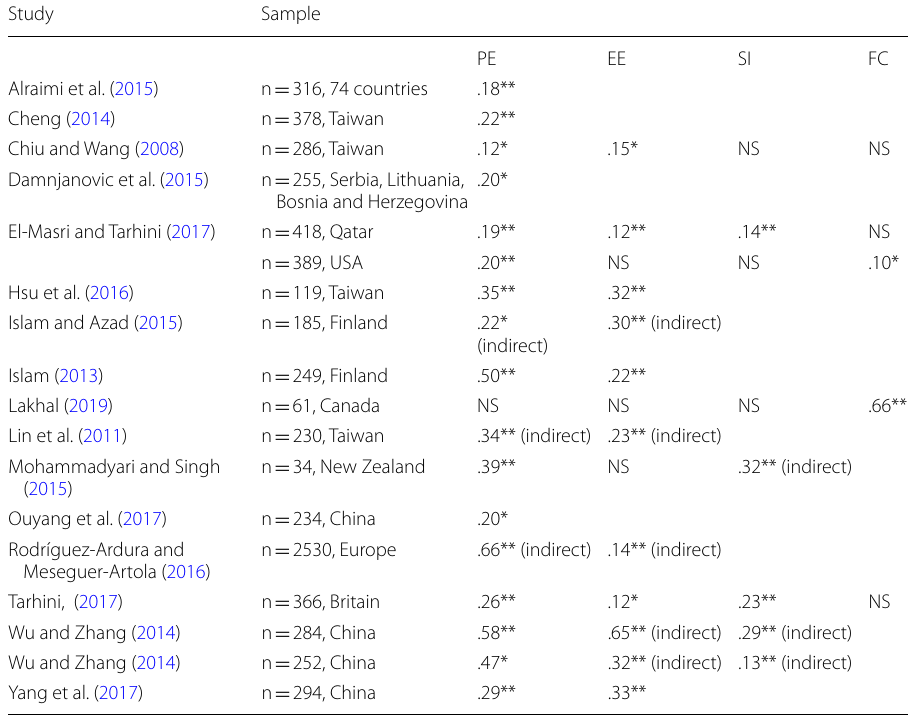
PE performance expectancy, EE effort expectancy, SI social influence, FC facilitating conditions. * p < 0.05, ** p < 0.01, NS: